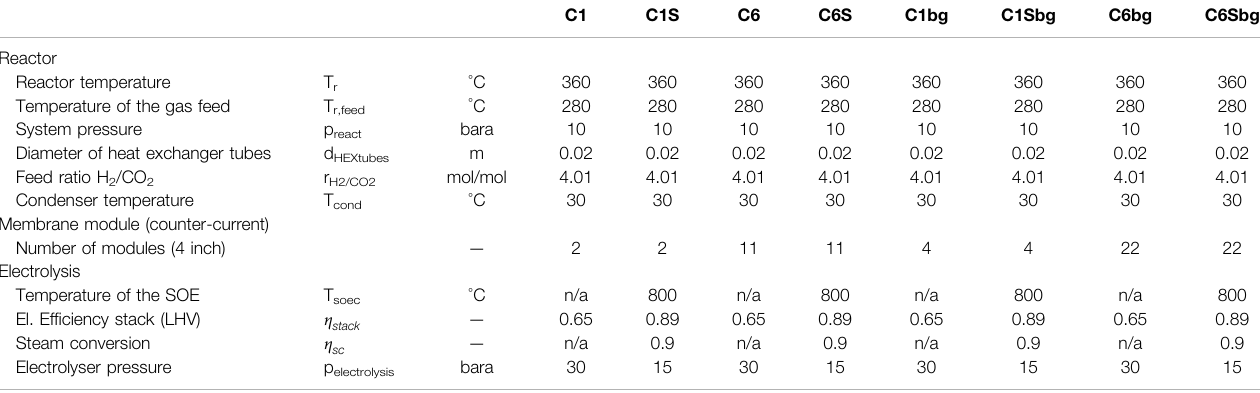
TABLE 3 | Input parameters for the bubbling fl uidised bed-based processes for CO 2 methanation, including the parameters for the sub-systems reactor, membrane upgrading and